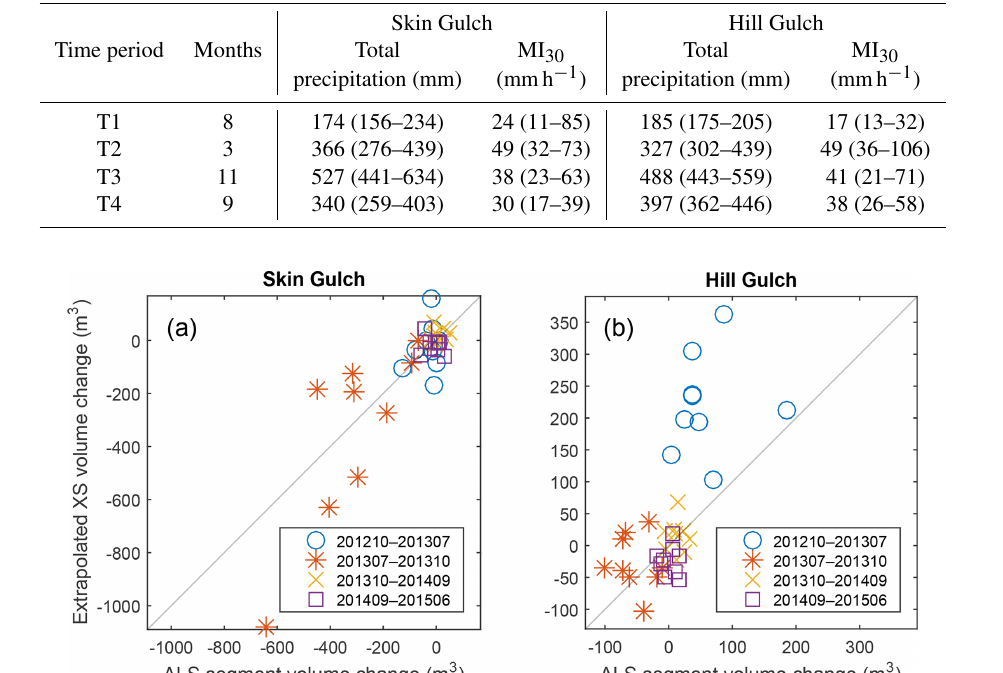
Table 2. Mean total precipitation and mean maximum 30min intensities (MI 30 ) for Skin Gulch and Hill Gulch for each time period. Ranges are in parentheses, and the values are derived from the gage-corrected radar data.